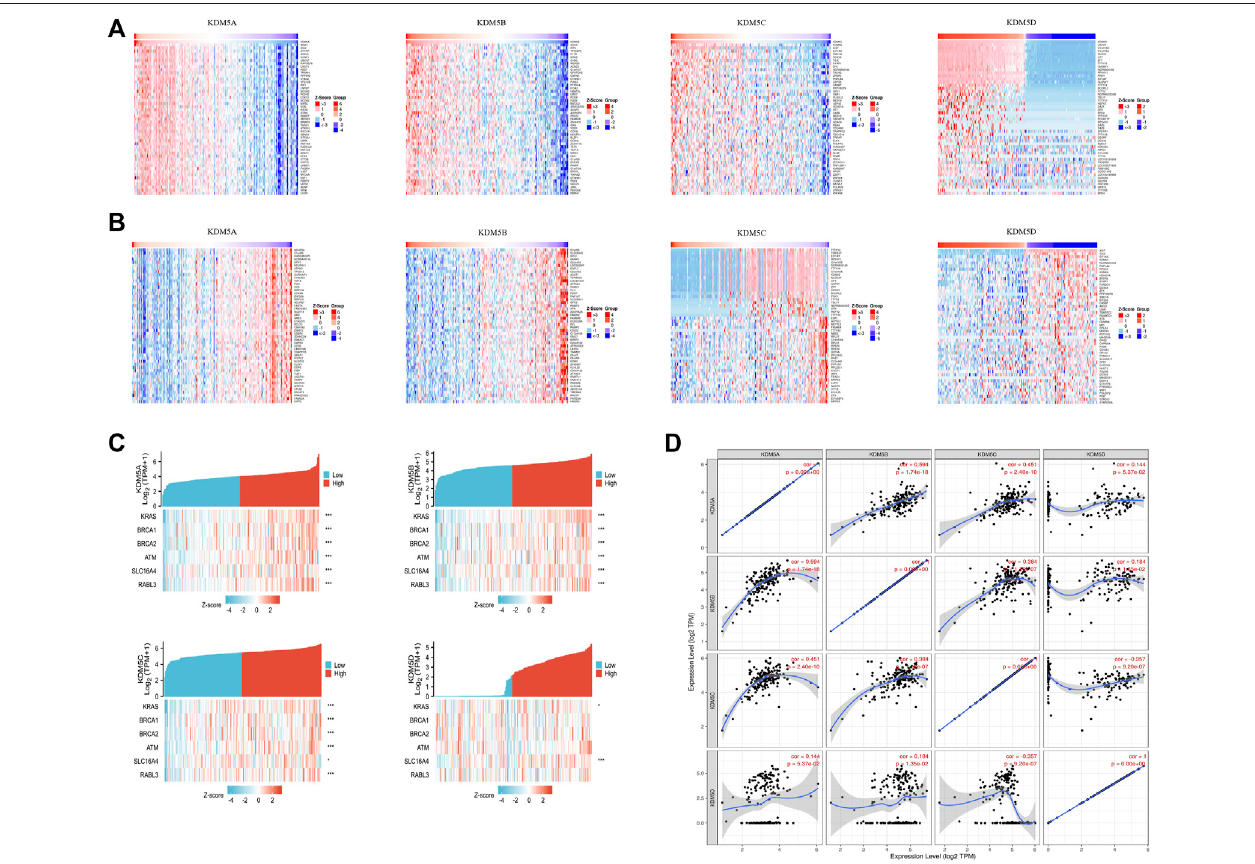
FIGURE 5 | The top 50 positively correlated genes and top 50 negatively correlated genes of the KDM5 family genes in patients with PAAD; Co-expression correlations of KDM5 family members and pathogenic genes of PAAD. (A) The top 50 genes with a positive correlation with KDM5 family genes are visualized in a heatmap; (B) Thetop50geneswithanegativecorrelationwithKDM5familygenesarevisualizedinaheatmap; (C) TheexpressionofKDM5A/B/Cispositivelycorrelated with the expression of KRAS, BRCA1, BRCA2, ATM, SLC16A4 and RABL3. *, p < 0.05; **, p < 0.01; ***, p < 0.001; (D) The expression of each KDM5 family member is signi fi cantly positively correlated.